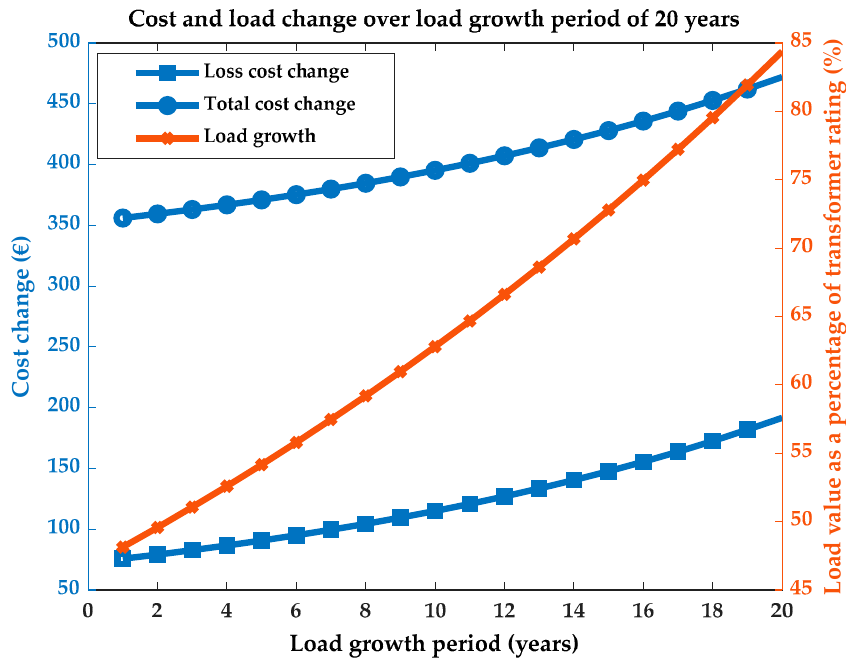
Figure 4. Cost and load changes of transformer over load growth period for the rural region with a load growth rate of 3% .